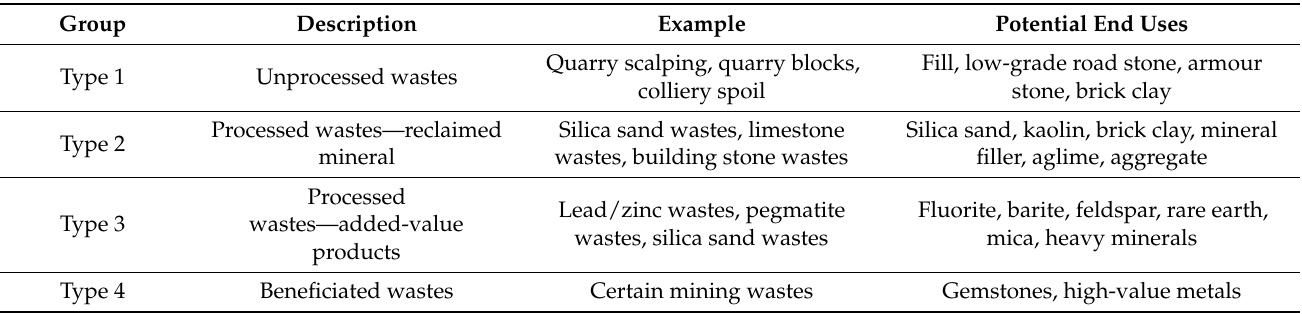
Table 1. Classification of mineral wastes according to Mitchell